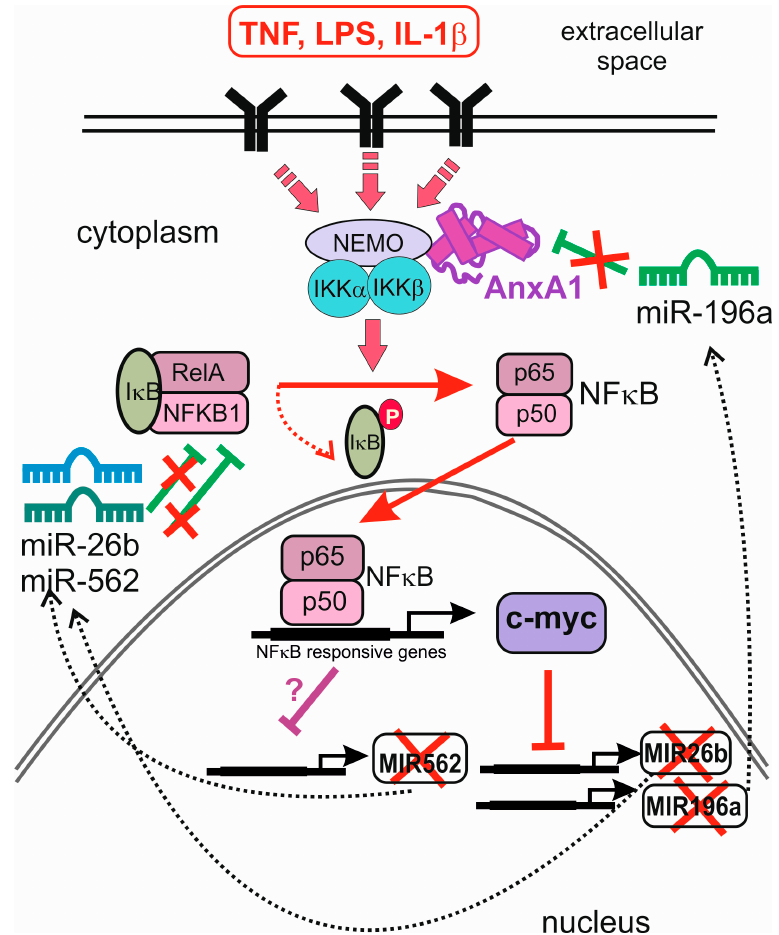
Figure 2. Reciprocal influence of annexin A1 and miRNAs in the regulation of NF κ B signalling. Annexin A1 interacts with Inhibitor of Nuclear Factor Kappa B Kinase Subunit Gamma (NEMO) and enhances NF κ B signalling (pink arrows), promoting phosphorylation and subsequent degradation of NF κ B inhibitor (I κ B, red dotted line) and activating transcription of NF κ B-regulated c-myc. c-Myc (red T-bar) and other NF κ B-responsive gene products (purple T-bar) inhibit transcription of MIR562, MIR26b, and MIR196a genes, and reduce the levels of mature miRNAs in the cytoplasm (dotted arrows). This relieves the suppressive effect of miR-26b and miR-562 on their targets, RelA and NF κ B1, and the downregulation of annexin A1 by miR-196a (green T-bars, crossed). Thus, annexin A1 inhibits miRNAs miR-196a, miR-562, and miR-26b in a negative feedback loop, through NF κ B and c-myc.